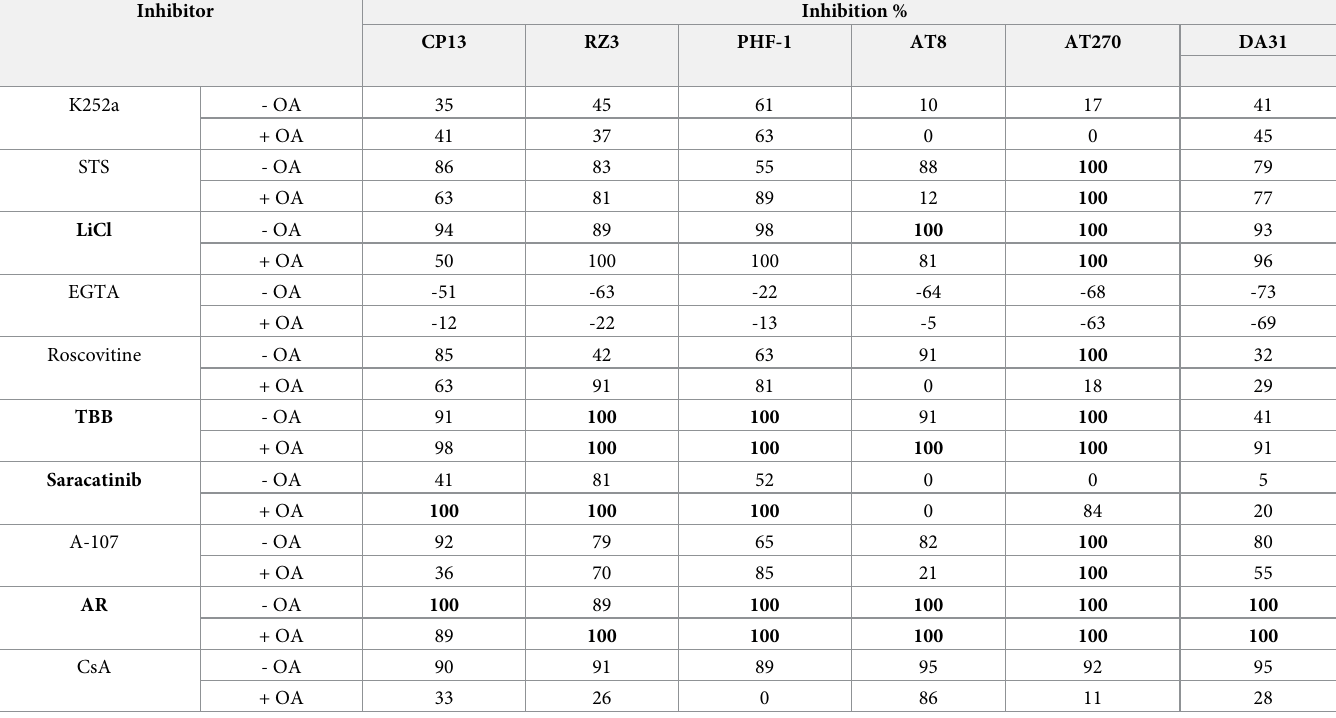
A negative sign correspond to an adverse effect. Bold corresponds to maximal inhibition at the tested epitope. The -/+ OA indicates either the presence or absence of okadaic acid compound. The densitometric intensity of 67 kDa band from Fig 4 and Fig 5 was used for calculating the percentage of inhibition. -13%), AT8 (-OA: -64%, +OA: -5%), AT270 (-OA: -68%, +OA: -63%), and total tau DA31 (-OA: -73%, +OA: -69%) ( Fig 4A and 4B, lane 5 and Fig 5A and 5B, lane 6; Table 4 ). Taken all together, treatments with CKII inhibitor TBB, GSK3 inhibitors LiCl and AR, and